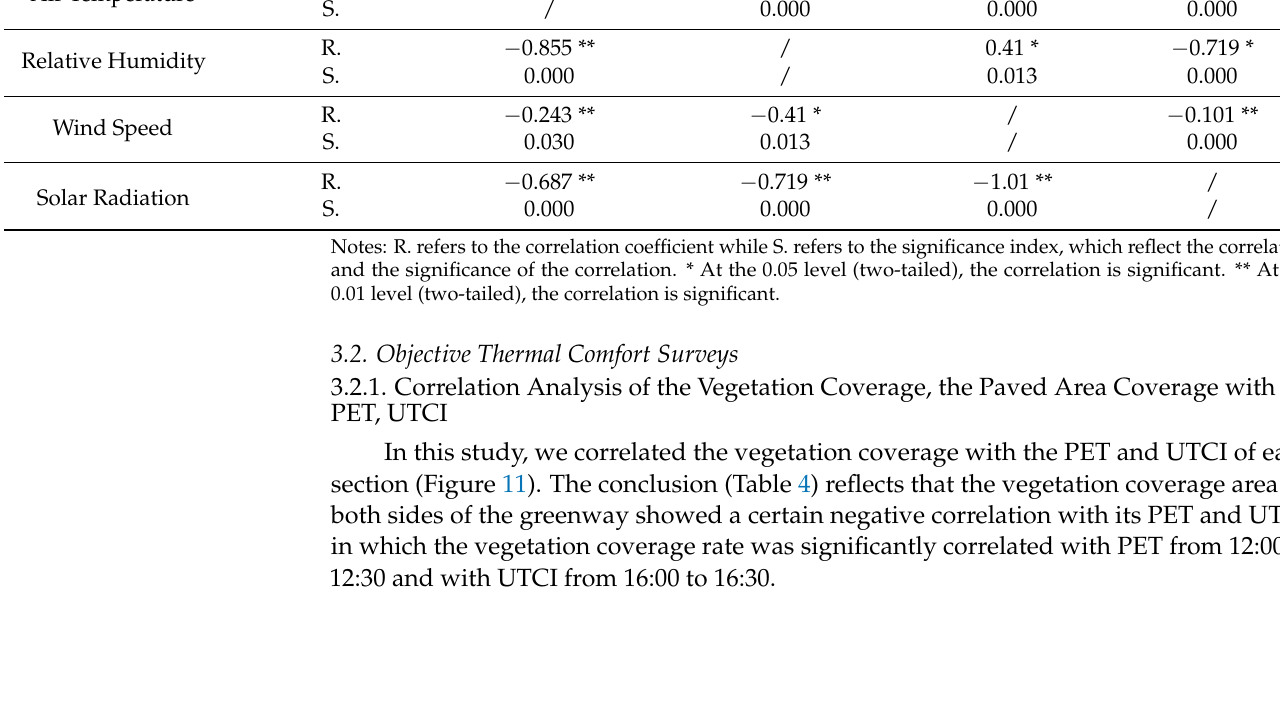
Table 3. The Spearman correlation analysis of measured parameters.